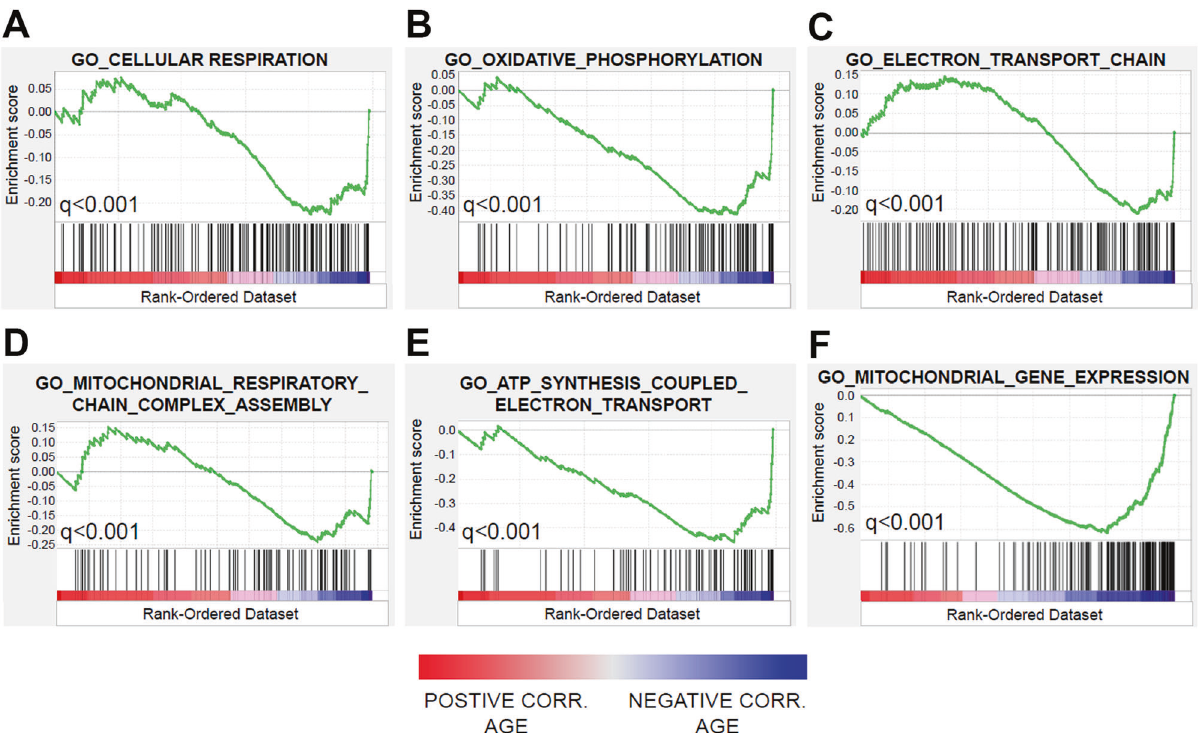
Fig. 2 Genes inversely correlated with patient age are enriched for mitochondrial functions. A – E RNA sequence data for 25 baseline bone marrow samples from the combined phase I + II cohorts were analyzed for gene expression patterns correlated with patient age. Genes were ranked on Pearson correlation coef fi cients and analyzed using the Gene Set Enrichment Analysis (GSEA) tool kit and Molecular Signatures Database. Shown are the top most enriched gene sets negatively associated with age. No signi fi cant enrichment was observed for positively correlated genes. F The most signi fi cant age-gene expression gene set from the OHSU AML RNAseq dataset of 239 baseline bone marrows is shown, con fi rming the negative association between mitochondrial AML gene expression and patient age. In this dataset, the gene sets represented in panels A – E also showed signi fi cant enrichment ( q < 0.004 for all gene sets). Enrichment scores (green line) and their corresponding false discovery rate-adjusted signi fi cance ( q values) are shown. Black vertical bars indicate the relative position of genes belonging to the gene set along the rank-ordered dataset. GO Gene Ontology GO